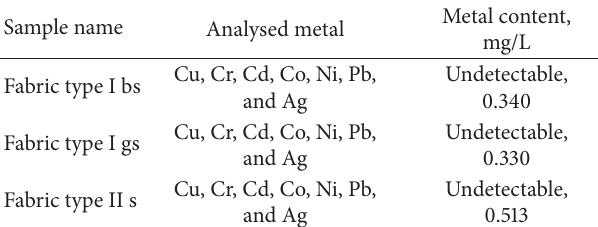
Table 3: Heavy metal content of samples with antimicrobial treat-